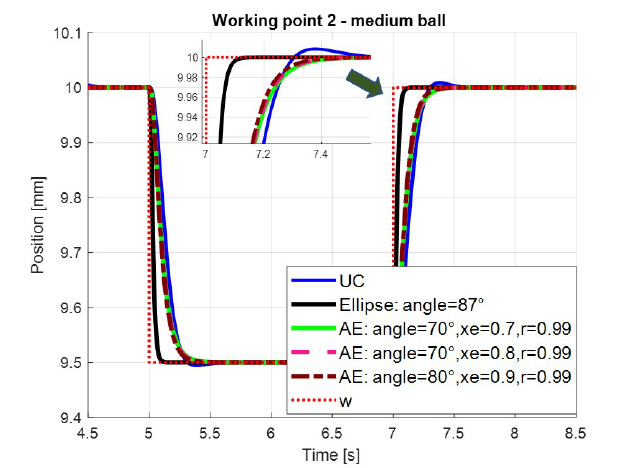
Figure 6. Step responses simulated on nonlinear model for the 2nd working point (medium ball) with the proposed pole-placement controllers according to legend.